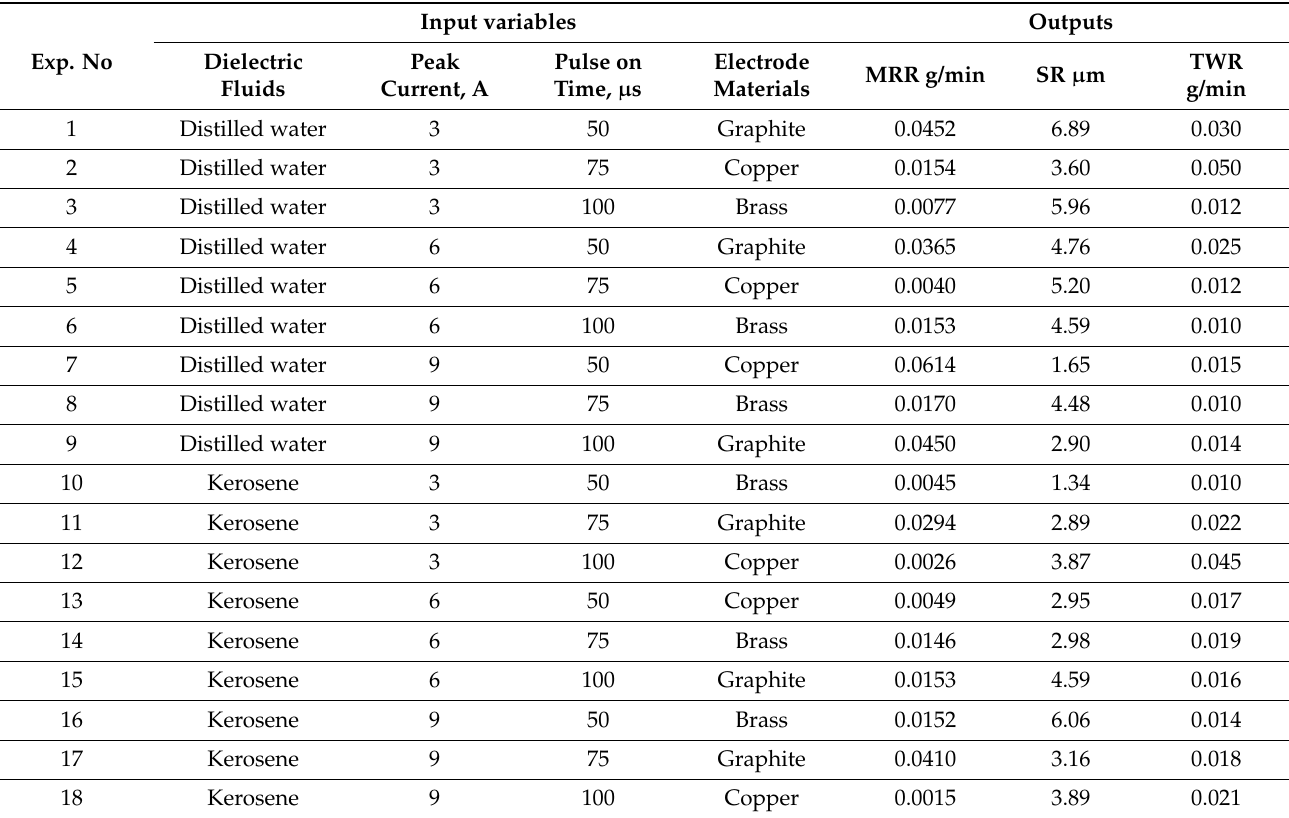
Table 6. L 18 experimental matrix and output results of signal-to-noise (S/N)